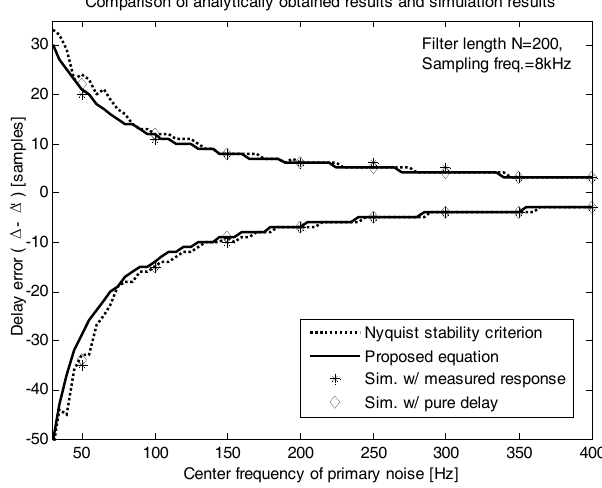
Figure 8. Comparison of stability bounds obtained with the analytic methods and simulations. Nyquist criterion (dotted line), proposed equation (solid line), simulation with the secondary path model measured from a commercial headphones (star), simulation with pure delay secondary path model (diamond).